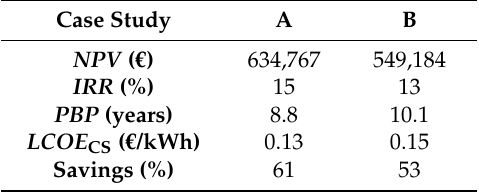
Table 11. Economic results of the Alter do Ch ã o PV-diesel drip irrigation